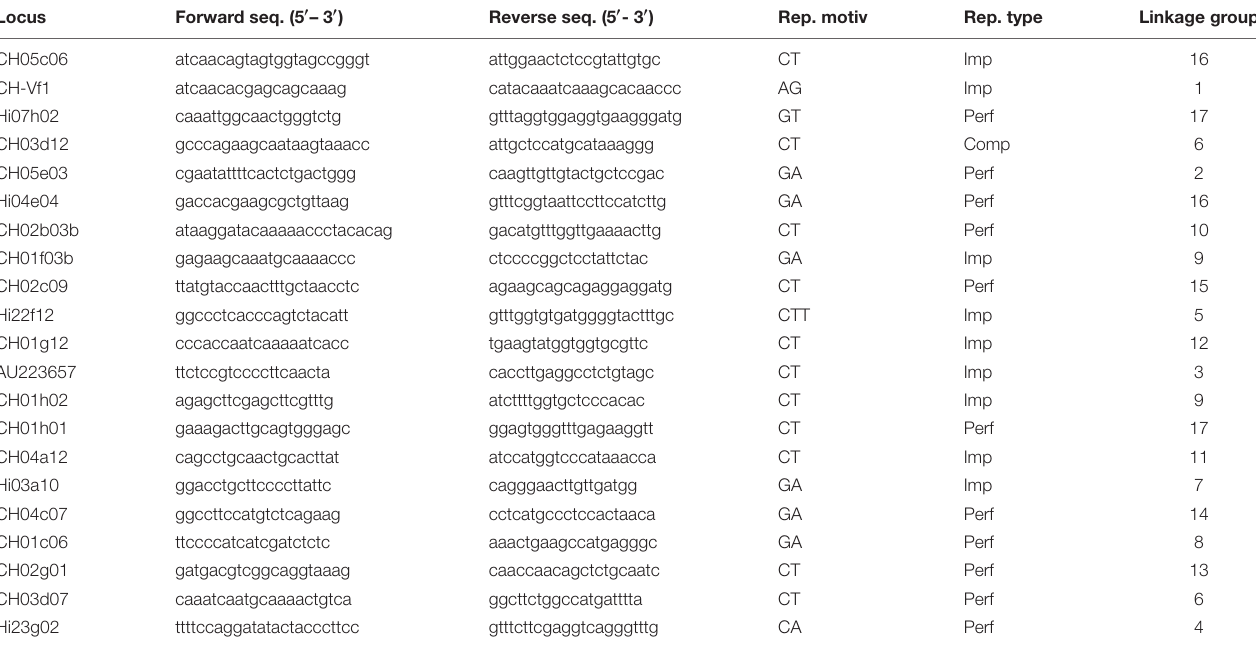
TABLE 2 | Characteristics of the 19 SSR markers used in the study, forward and reverse sequences, repetitive motives and types (Perfect, Imperfect, Compound), and linkage group. Locus Forward seq. (5 (cid:48) – 3 (cid:48) ) Reverse seq. (5 (cid:48) - 3 (cid:48)